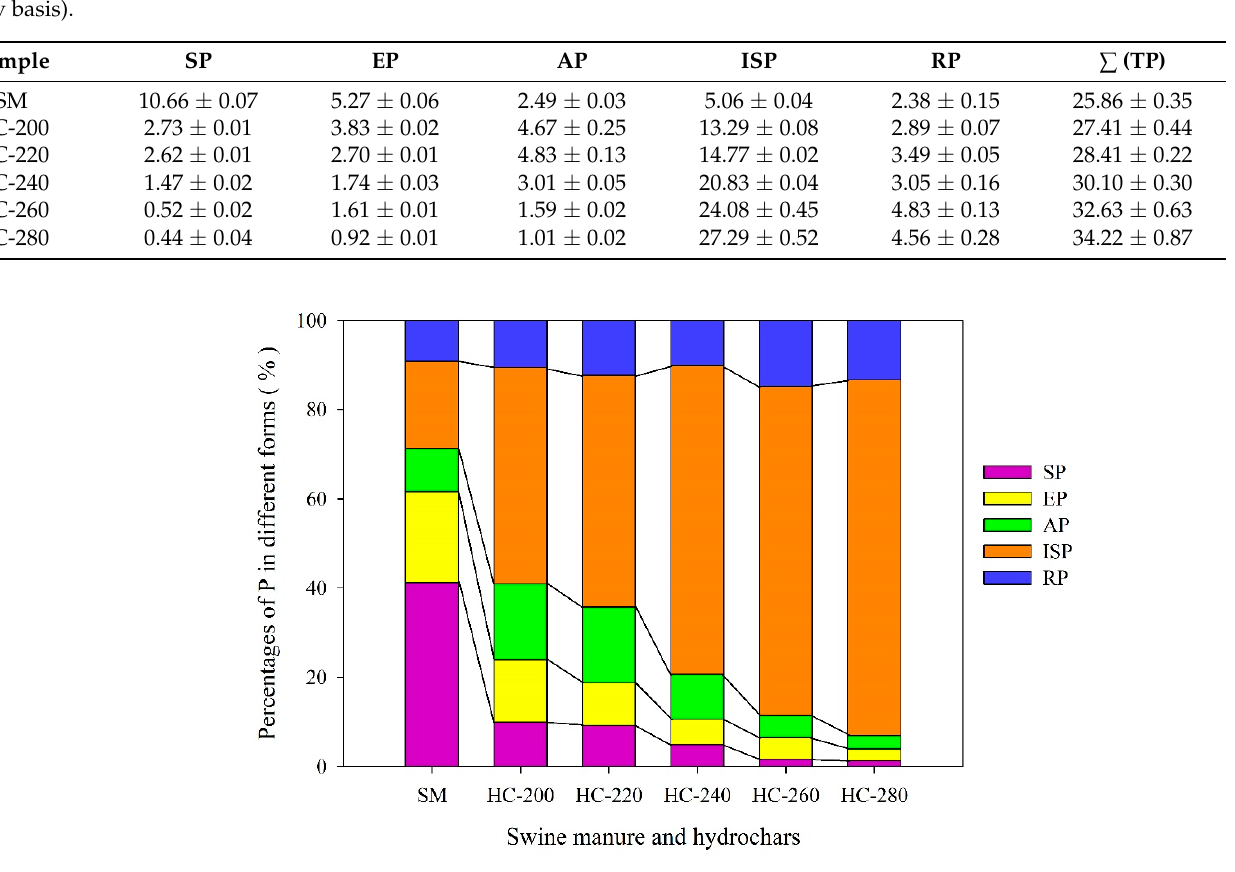
Figure 3. Changes in the forms of P between raw SM and hydrochars obtained at different reaction temperatures.